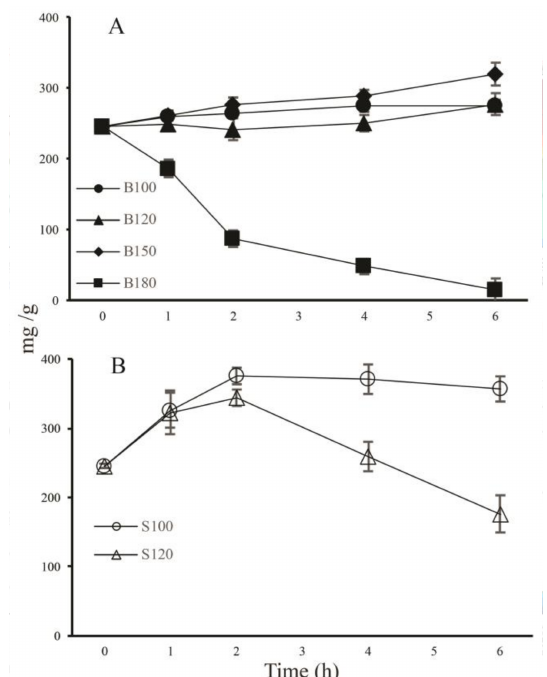
Figure 2. Total contents of 20 ginsenosides in unheated and heated ginseng flowers. ( A ) Ginseng flowers baked at 100 (B100), 120 (B120), 150 (B150) and 180 (B180) ◦ C for (0)1–6 h; ( B ) Ginseng flowers steamed at 100 (S100) and 120 (S120) ◦ C for (0)1–6 h. Data at 0 h represent those of unheated ginseng flowers (UGF). Values are denoted as the mean ± standard deviation ( n =